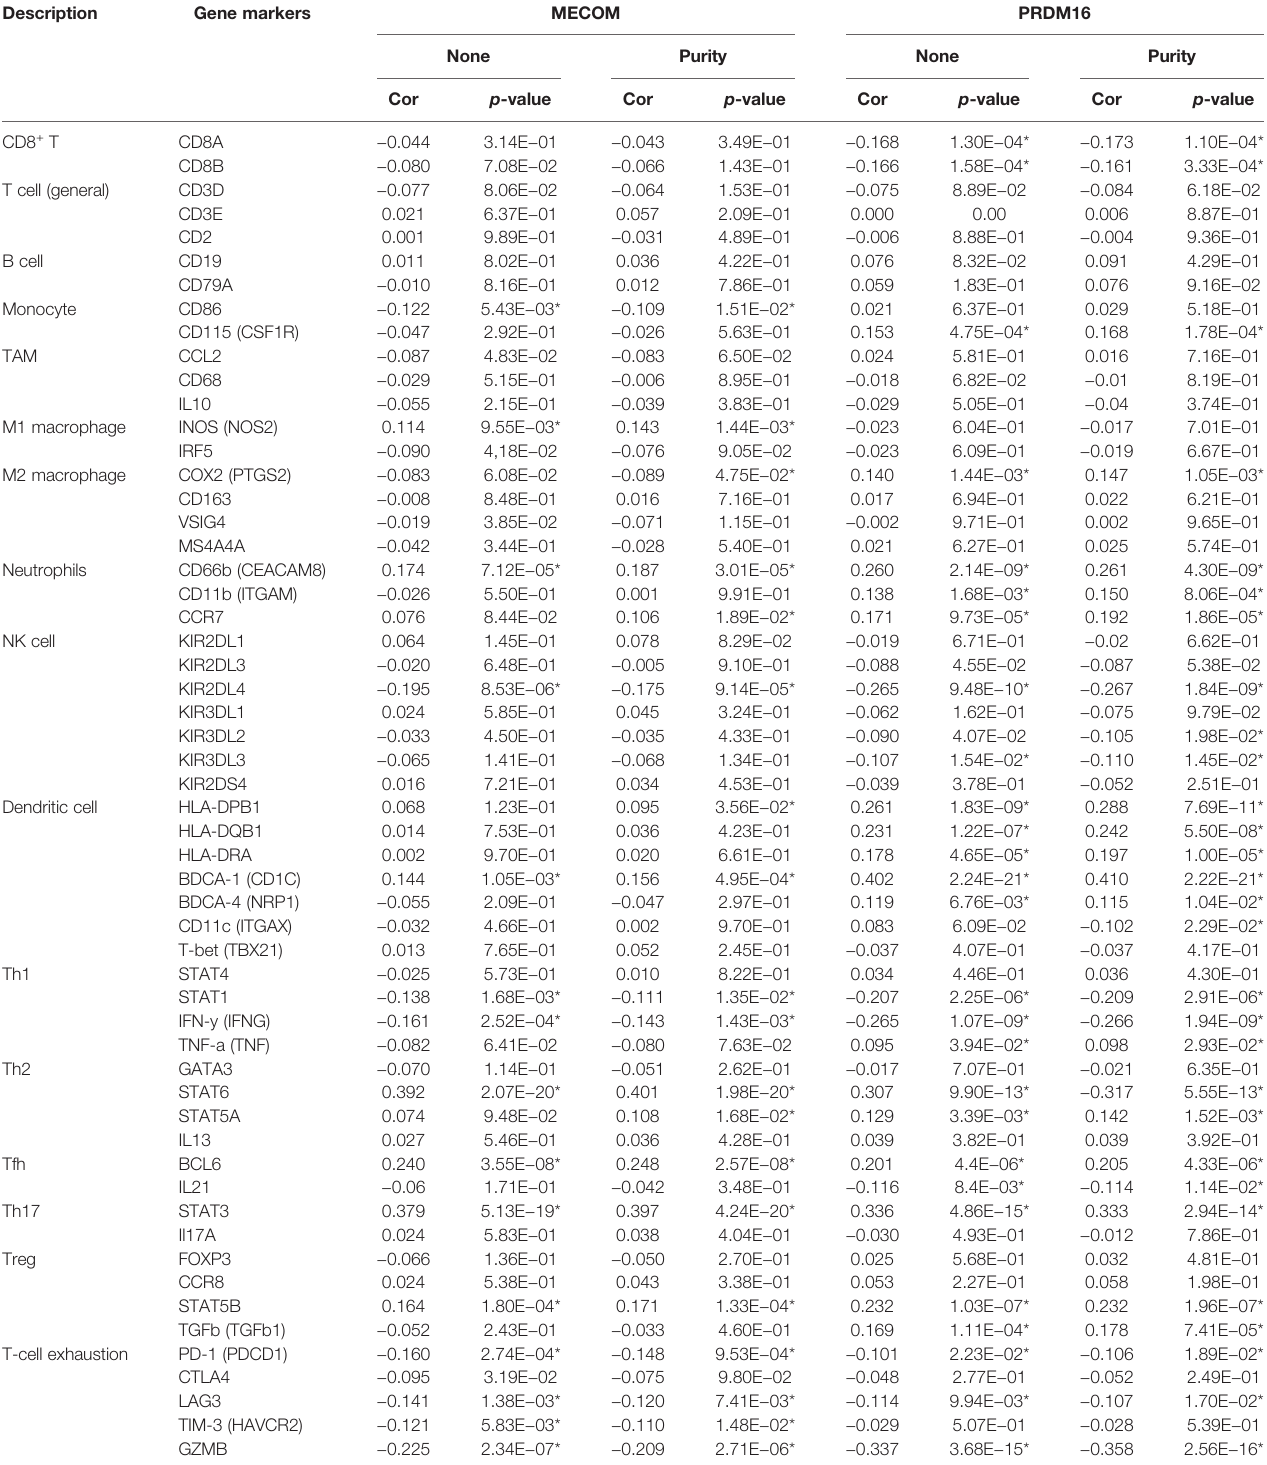
TABLE 1 | Correlation analysis between MECOM, PRDM16, and gene markers of immune cells in TIMER.